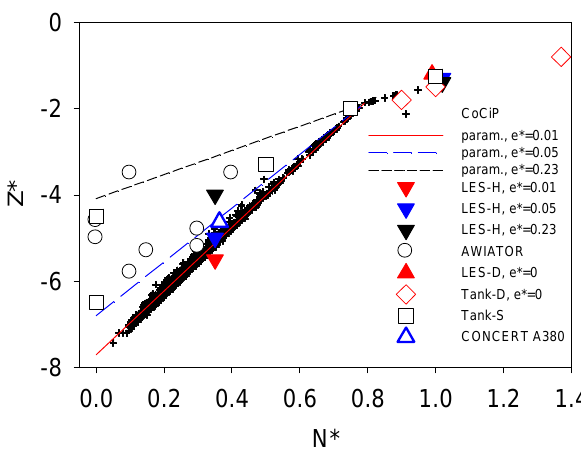
Fig. 4. Initial contrail depth (black) and width (blue) versus air- Fig. 3. Non-dimensional maximum wake vortex sinking dis- craft mass for an example traffic and meteorology over the North tance versus nondimensional stratification. Z ∗ = − 1z w /b 0 , b 0 = Atlantic 6–9 June 2006. Each point corresponds to an aircraft at a (π/ 4 )s a , N ∗ = N BV t 0 , t 0 = 2 πb 2 /0 0 , 0 0 = M a g 4 /(πs a ρV a ) . given position. Following the International System of Units (NIST, 0 Crosses depict CoCiP results. The deviation from a piece-wise 2008), non-dimensional axis values (here: mass/Mg) represent the straight line is a consequence of different (non-dimensional) tur- quantity plotted (mass) divided by the given unit bulent dissipation rates (cid:15) ∗ = ((cid:15)b 0 ) 1 / 3 /w 0 , w 0 = b 0 /t 0 . The lines depict the parameterization for fixed (cid:15) ∗ = 0.01, 0.05 and 0.23 (red, blue, black) (Holz¨apfel, 2003). Filled symbols with correspond- ing colors are LES results (Hennemann, 2010; Delisi and Robins, 2000). Open symbols are experimental results in tanks (Sarpkaya, 1983; Delisi and Robins, 2000) and behind aircraft (deBruin and Kannemans, 2004; Voigt et al., 2011) (projects AWIATOR and CONCERT).